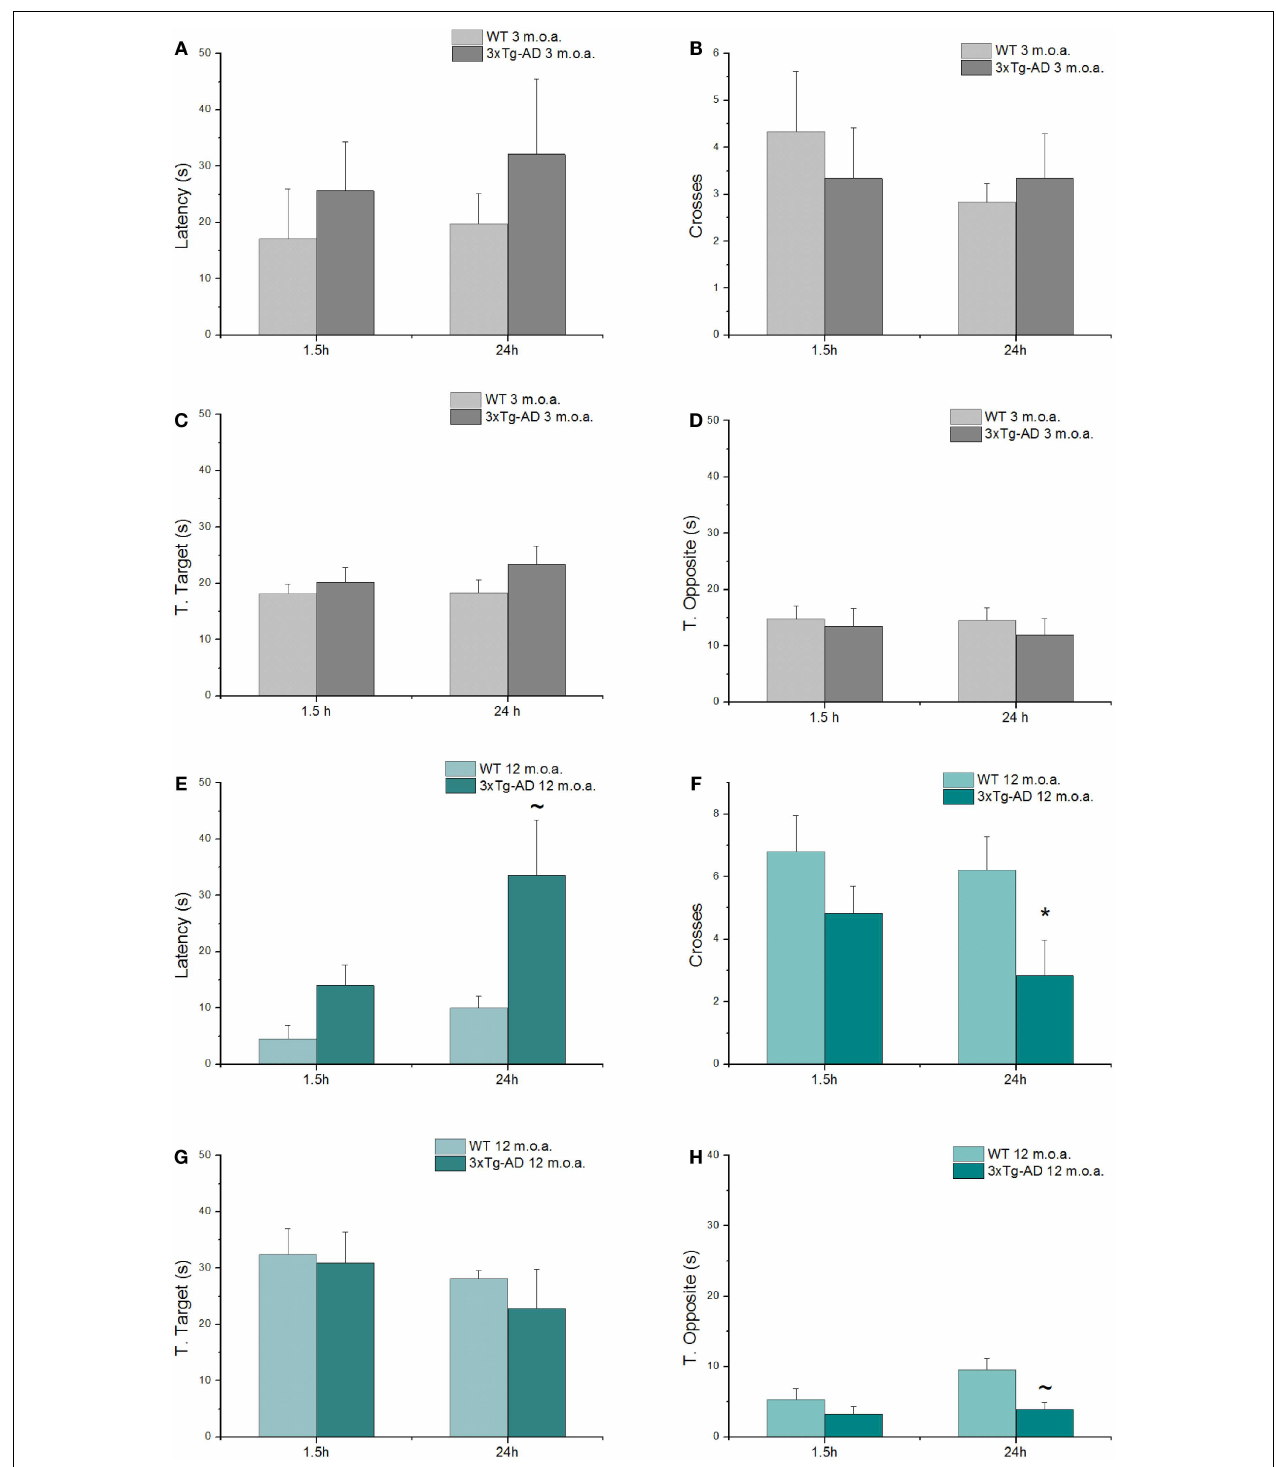
was impaired as indicated by statistically significant reduction in number of crosses (* p = 0.022) and increase in time (latency; ~ p = 0.092) that animals employed to reach the point where the platform used to be. Results are expressed as mean values ± SEM. P value is the result of two-factor ANOVA and Fisher’s least significant difference (LSD) post hoc test (* p < 0.05; ~trend 0.05 < p <